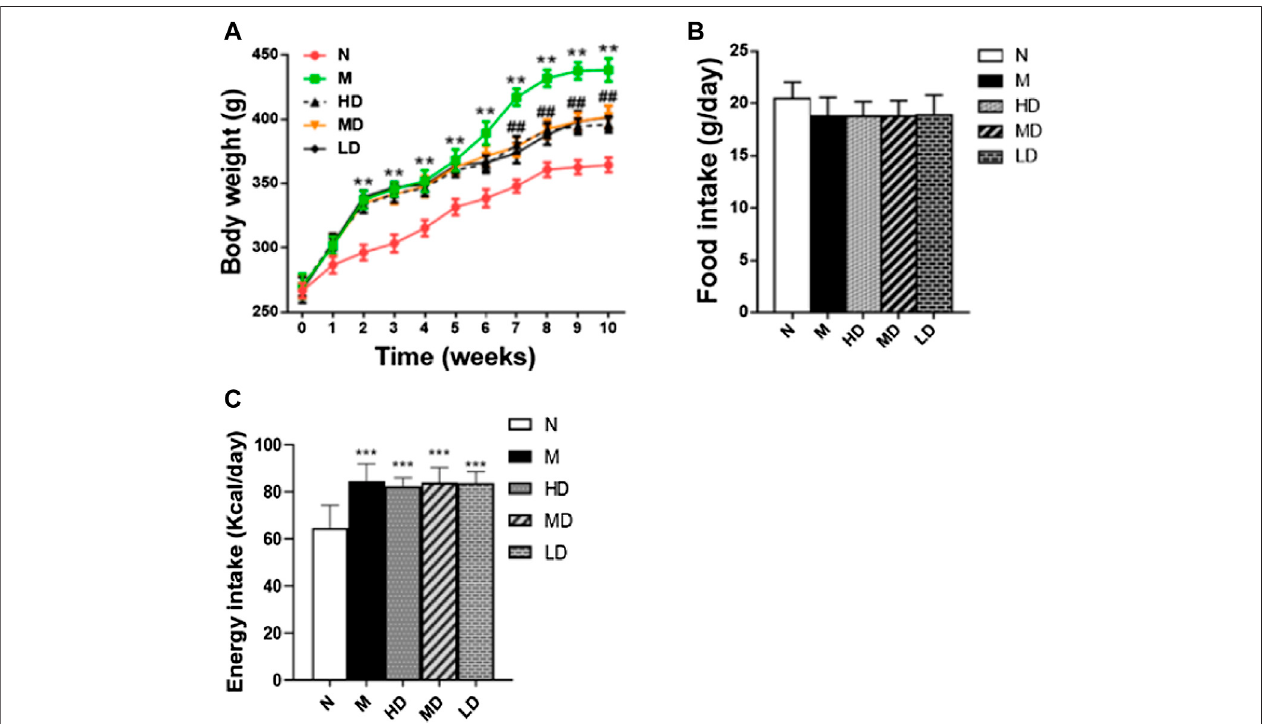
FIGURE 1 | Effects of CQR on body weight. (A) , food intake. (B) and Energy intake. (C) in rats fed with high fat diet. Data are expressed as mean ± SEM ( n (cid:1) 10). * p < 0.05, ** p < 0.01,*** p < 0.001 vs. Ngroup; # p < 0.05, ## p < 0.01 vs. Mgroup (N,normaldiet group;M, model group; HD,high dosegroup; MD,middledose group and LD, low dose group).